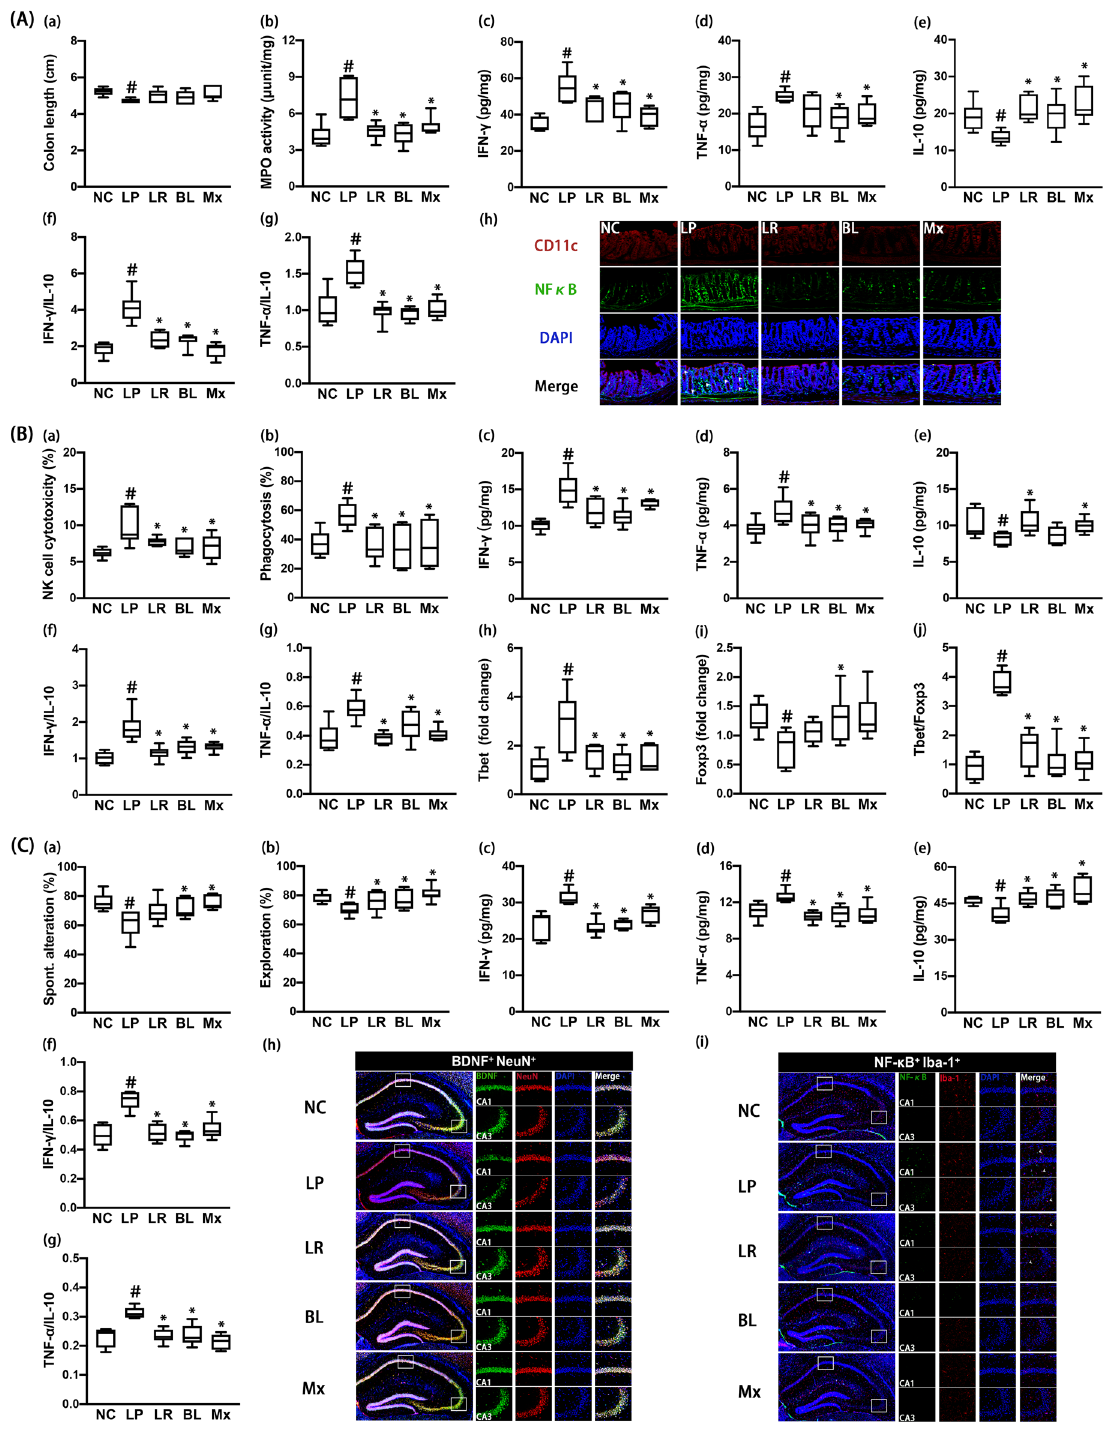
Figure 2. Effects of NK210 and NK219 on LPS-induced immune imbalance and cognitive impairment in mice. ( A ) Effects on colitis: colon length (a), myeloperoxidase (MPO) activity (b), IFN-γ (c), TNF-α (d), IL-10 expression (e), IFN-γ to IL-10 expression ratio (f), TNF-α to IL-10 expression ratio (g), and NF-κB + /CD11c + cell population in the colon (h). ( B ) Effects on the immune imbalance: splenic NK cell cytotoxicity activities (a), peritoneal macrophage phagocytosis (b), IFN-γ (c), TNF-α, (d), and IL-10 expression (e), IFN-γ to IL-10 expression ratio (f), TNF-α to IL-10 expression ratio (g), Tbet (h) and Foxp3 expression (i), and Tbet to Foxp3 expression ratio (j) in the spleen. ( C ) Effects on cognitive impairment in the Y-maze (a) and NOR task (b). Effects on neuroinflammation: IFN-γ (c), TNF-α (d), IL-10 expression (e), IFN-γ to IL-10 expression ratio (f), TNF-α to IL-10 expression ratio (g), and BDNF + /NeuN + and NF-κB + /Iba1 + cell populations (h) in the hippocampus. Test agents (LP, LPS alone; LR, 1 × 10 9 CFU/ mouse/day of NK210; BL, 1 × 10 9 CFU/mouse/day of NK219; Mx, 1 × 10 9 CFU/mouse/day of LR and BL [4:1] mix) were orally gavaged daily for 5 days after intraperitoneal injection of LPS. Normal control mice (NC) were treated with vehicle (saline) instead of test agents. Data values indicate mean ± SD (n = 8). # p < 0.05 versus NC group. * p < 0.05 versus LP group treated with LPS